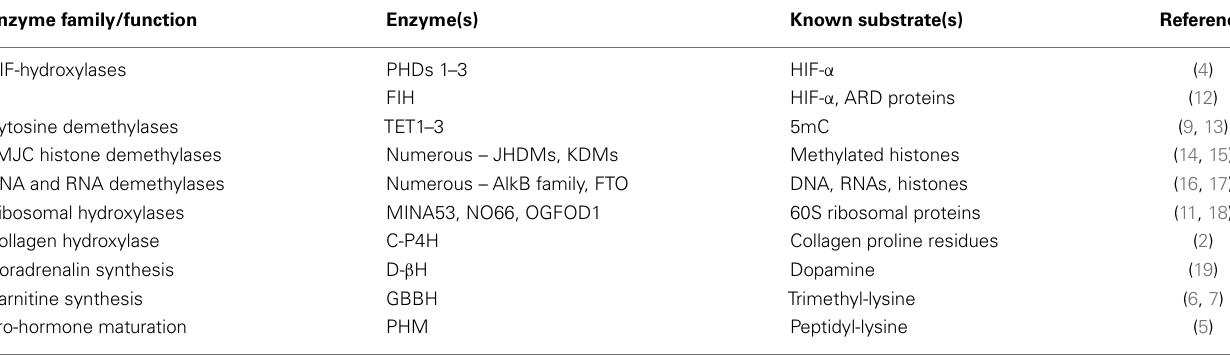
Table 1 |Various members of the 2-oxoglutarate dioxygenase family in mammalian cells, their known substrates, and biological functions